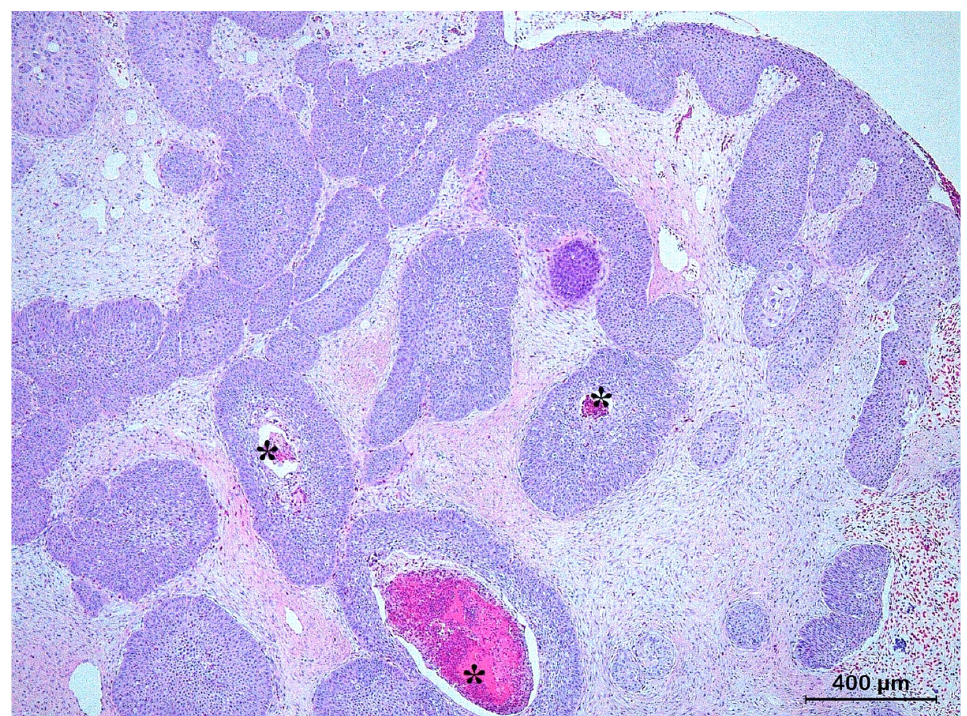
Figure 6. Histological section of a keratotic basal cell carcinoma from the skin of the body wall of a boa constrictor ( Boa constrictor ) characterized by cords of small polyhedral basaloid cells extending into the dermis and foci of abrupt squamous differentiation with central mature keratinization (asterisks). Infiltrating BCCs were mainly characterized by irregular, narrow (<8 cells thick), and elongated cords of small, atypical basophilic basal tumor cells, without differentiation into squamous epithelium that were deeply infiltrating into the dermis and subcutis (Figure 7). The neoplastic cells showed moderate to marked nuclear atypia, and mitotic activity was in response to the infiltrating neoplastic